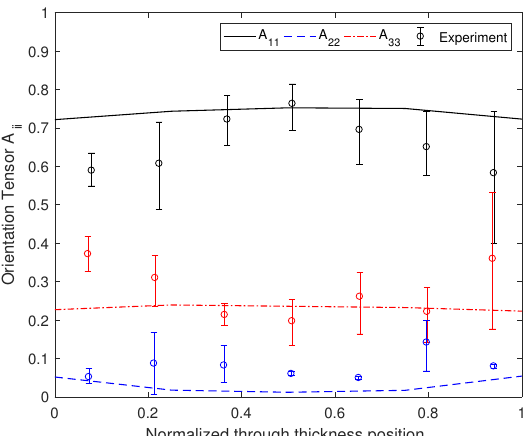
Figure 5. Final fiber orientation through thickness after a elongation time of 2 s at a constant strain rate of 0.5 s − 1 with experimental data from [17] in points and simulation data in continuous lines.